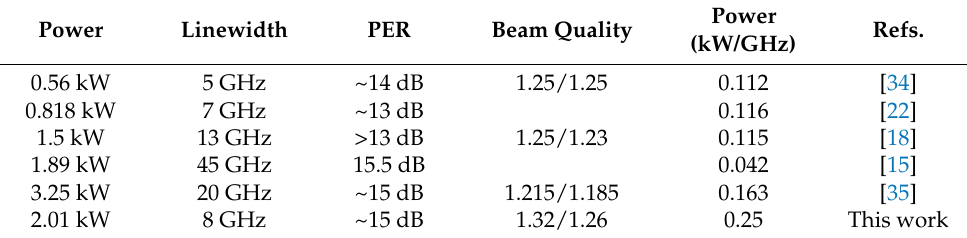
Table 1. Comparison of output properties for our fiber laser and previously reported narrow-linewidth fiber lasers based on the PM fiber. Power Linewidth PER Beam Quality